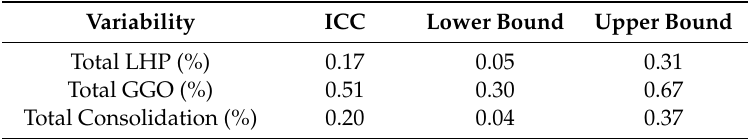
Table 2. The intraclass coe ffi cient (ICC) among quantitative volumes obtained using di ff erent commercial computerized tools. Variability ICC Lower Bound Upper